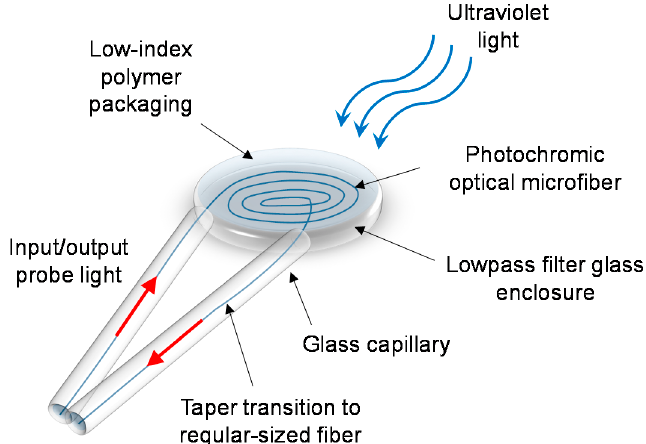
Figure 21. Schematic diagram of the ultraviolet-light sensor head.